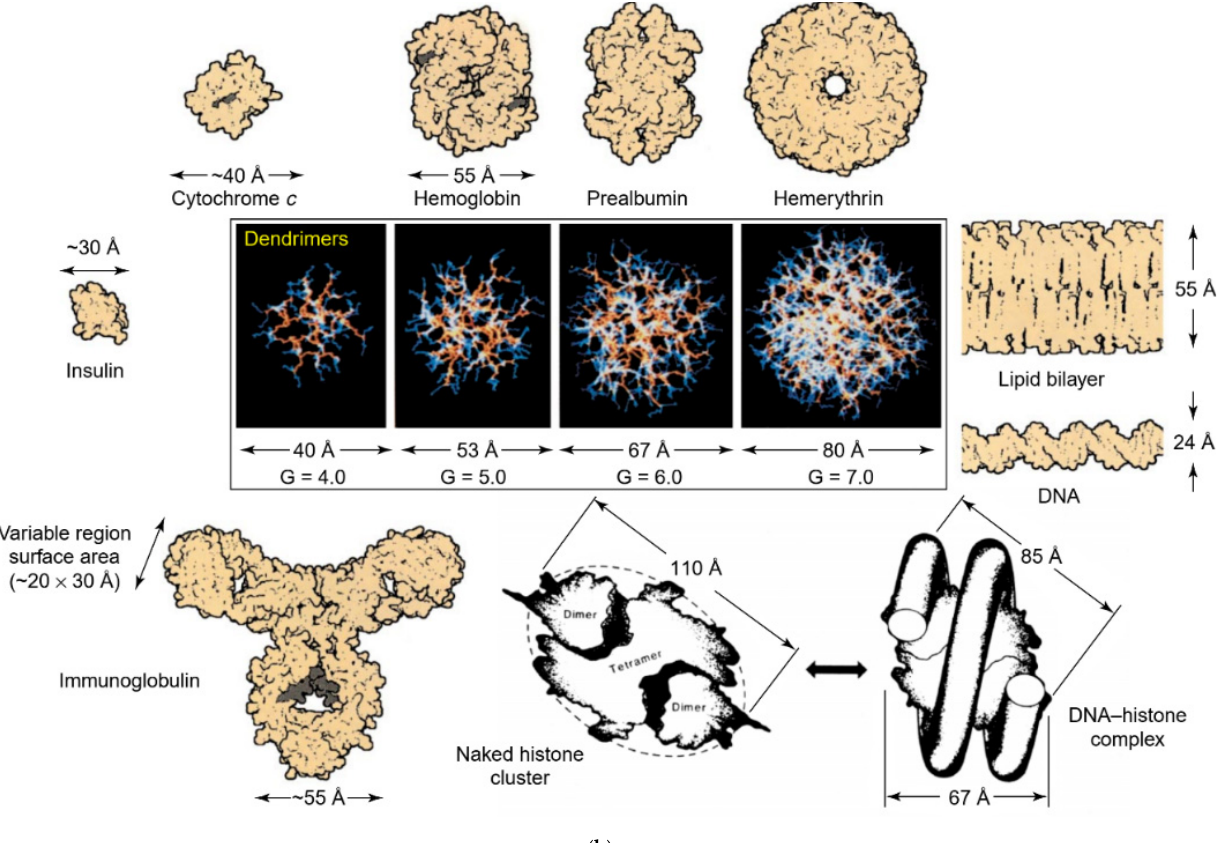
Figure 2. ( a ) Biomedical applications where functionalized dendritic polymers are important to probe biological interactions. Reproduced under creative commons license from [66]. ( b ) A dimensionally scaled comparison of a series of poly(amidoamine) (PAMAM) dendrimers (G = 4–7) with a variety of proteins, a typical lipid-bilayer membrane, and DNA, indicating the closely matched size and contours of important proteins and bio-assemblies. Reproduced with permission from [67]. Copyright: Elsevier Science